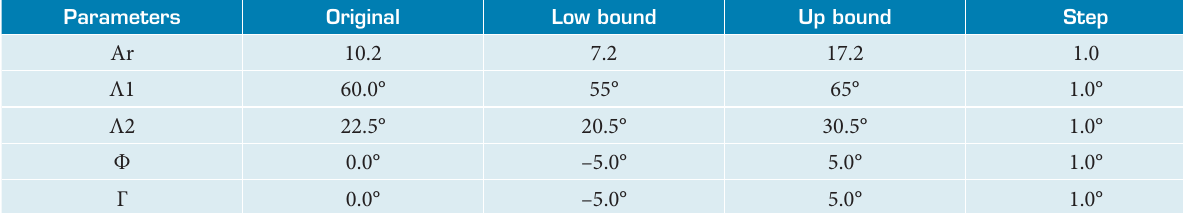
Table 2. Values of the design variables.